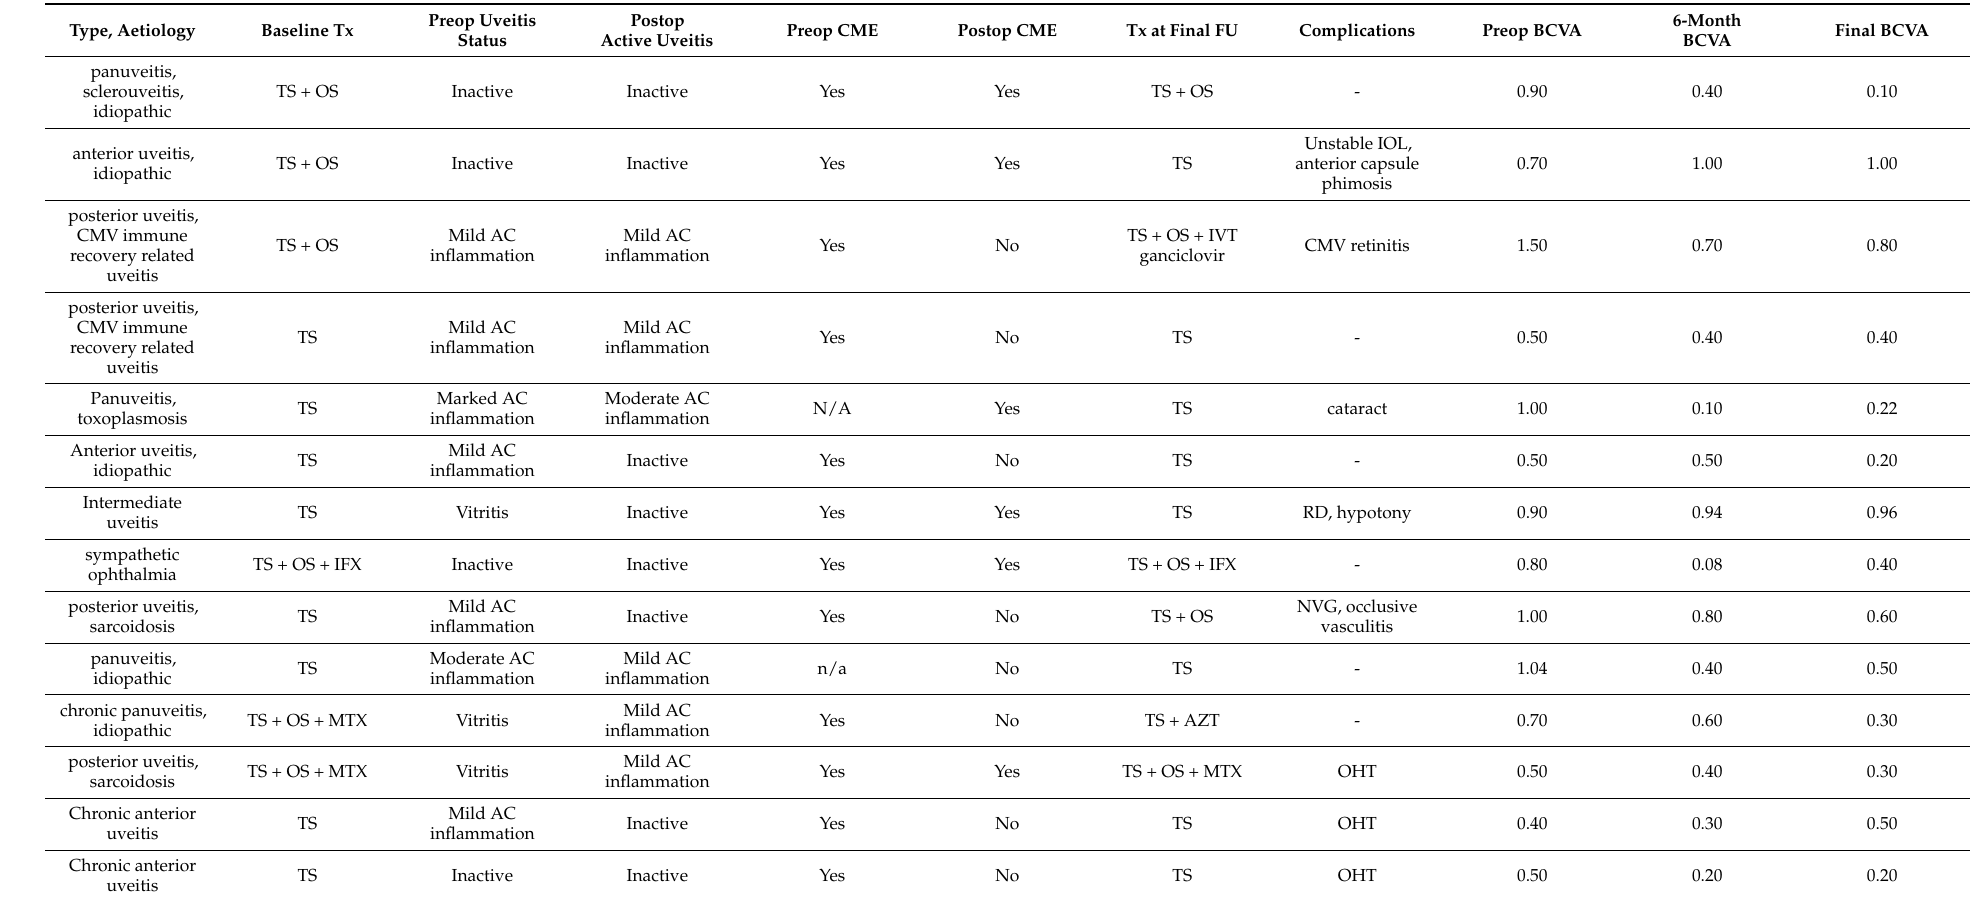
Table 1. Preoperative and postoperative uveitis